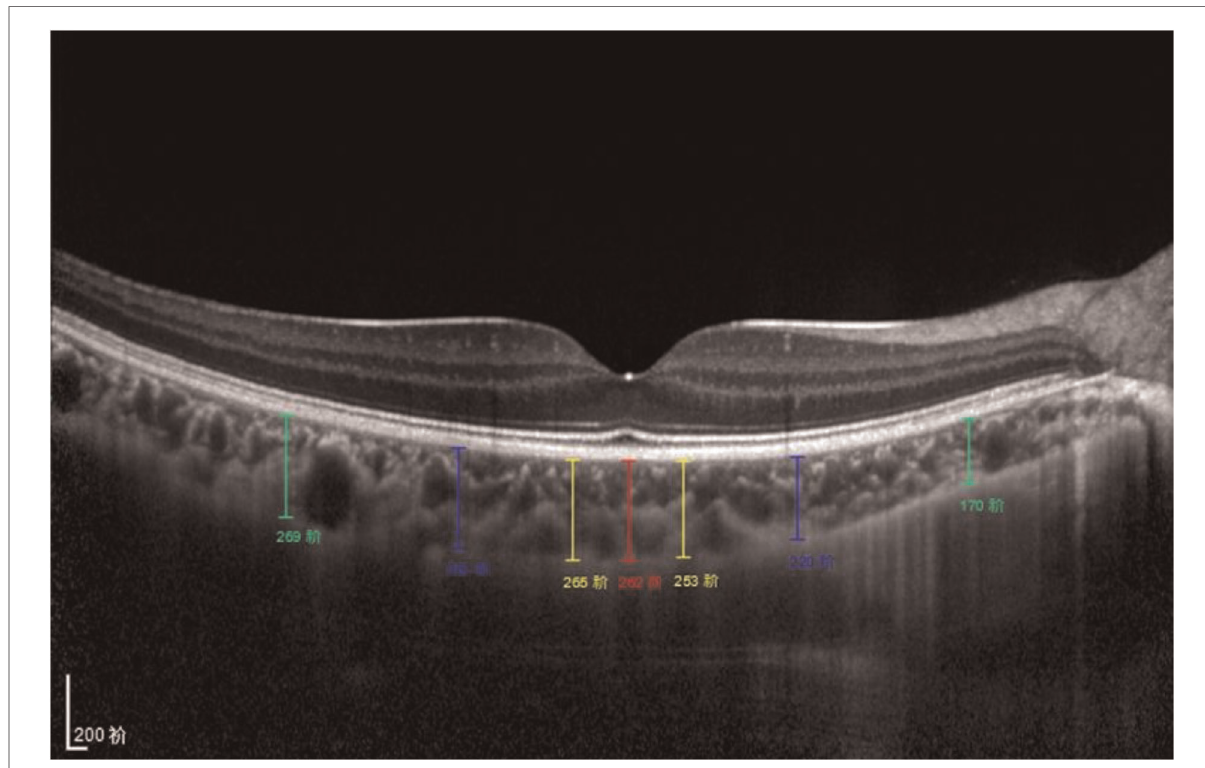
FIGURE 1 Subfoveal CT measurement. CT was measured at 7 points: directly beneath the fovea or the subfoveal area (SFCT) point, and 0.5/1.5/3 mm to the fovea nasally (N1/N2/N3), 0.5/1.5/3 mm to the fovea temporally